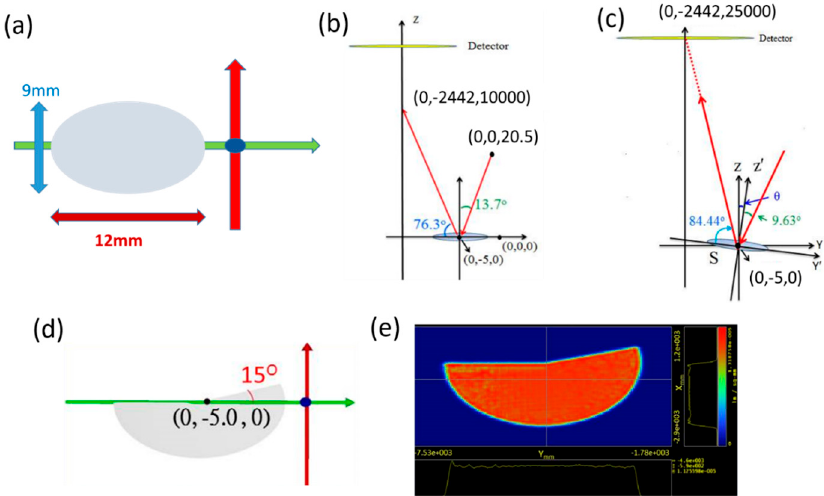
Figure 2. Map of the position of the reflector design: ( a ) elliptical reflector, ( b ) light reflected to coordinates (0, − 2442, 10,000), ( c ) light reflected to coordinates (0, − 2442, 25,000), ( d ) reflector in low beam mode, and ( e ) light field shape on the work plane in low beam mode.